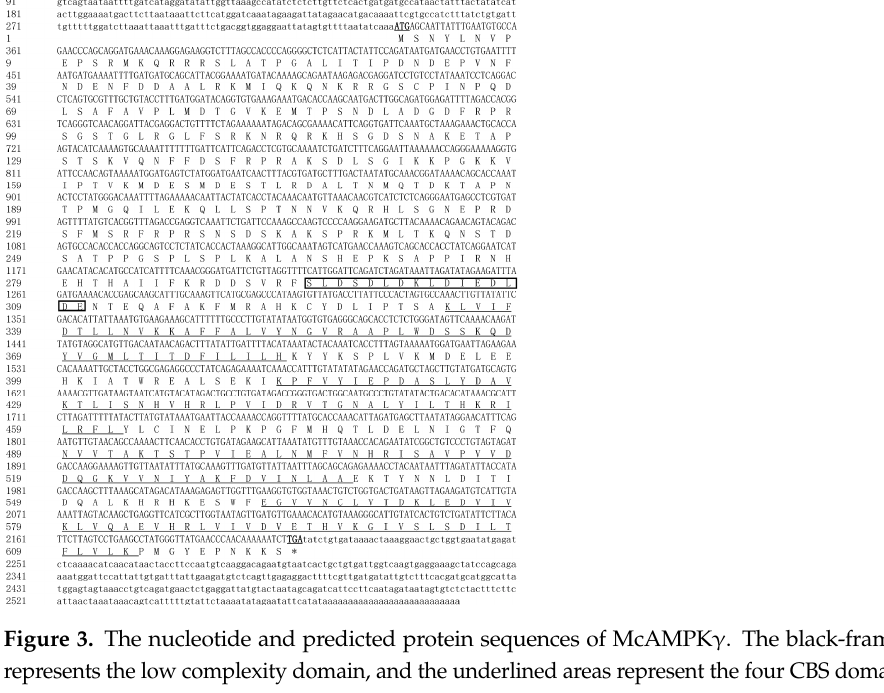
Figure 2. The nucleotide and predicted protein sequences of McAMPK β . The underlined areas rep- resent the CBM domain, and the black-framed regions represent the interaction domain, AMPKBI.